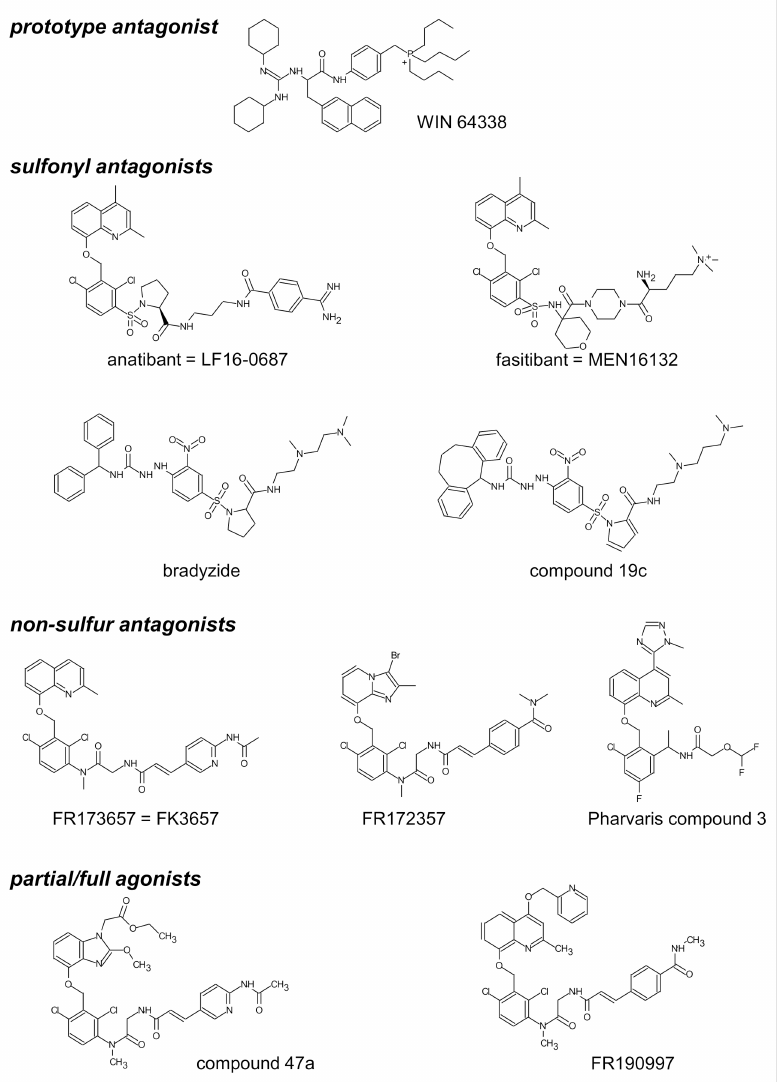
Figure 2. Structure of selected nonpeptide ligands of the B 2 R. Modified from [65] and [36]